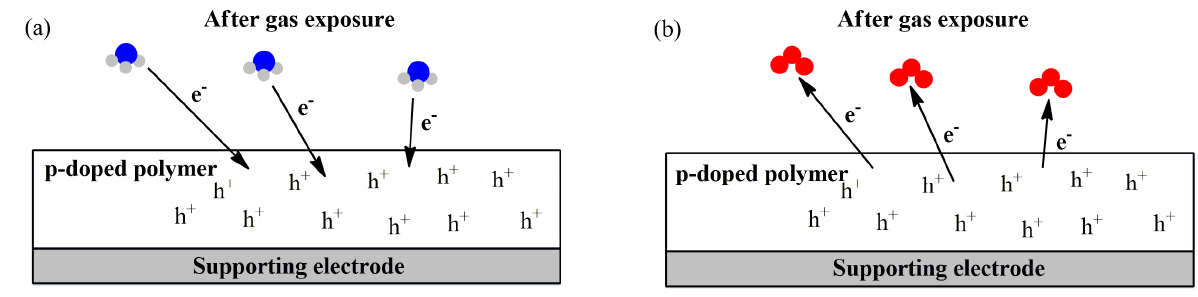
Figure 8. Overall mechanism of gas sensing using a reducing gas (NH 3 ) ( a ) and an oxidant gas (O 3 ) ( b ) as examples.